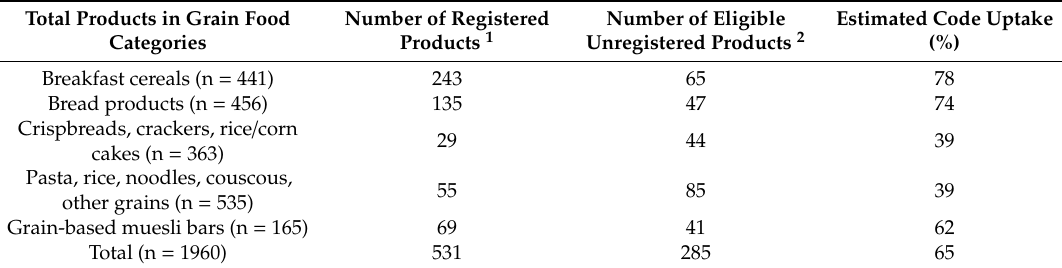
Table 1. Grain food categories and registered products as of June